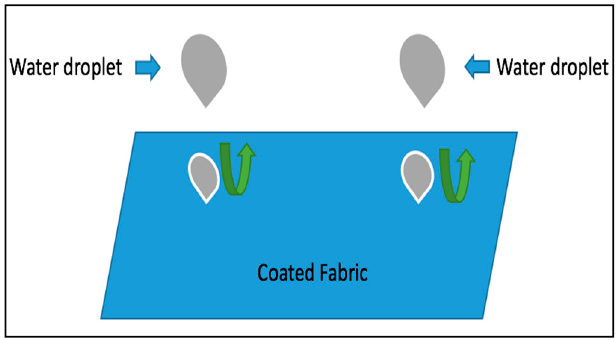
Figure 9. Water resistance of coated fabric.